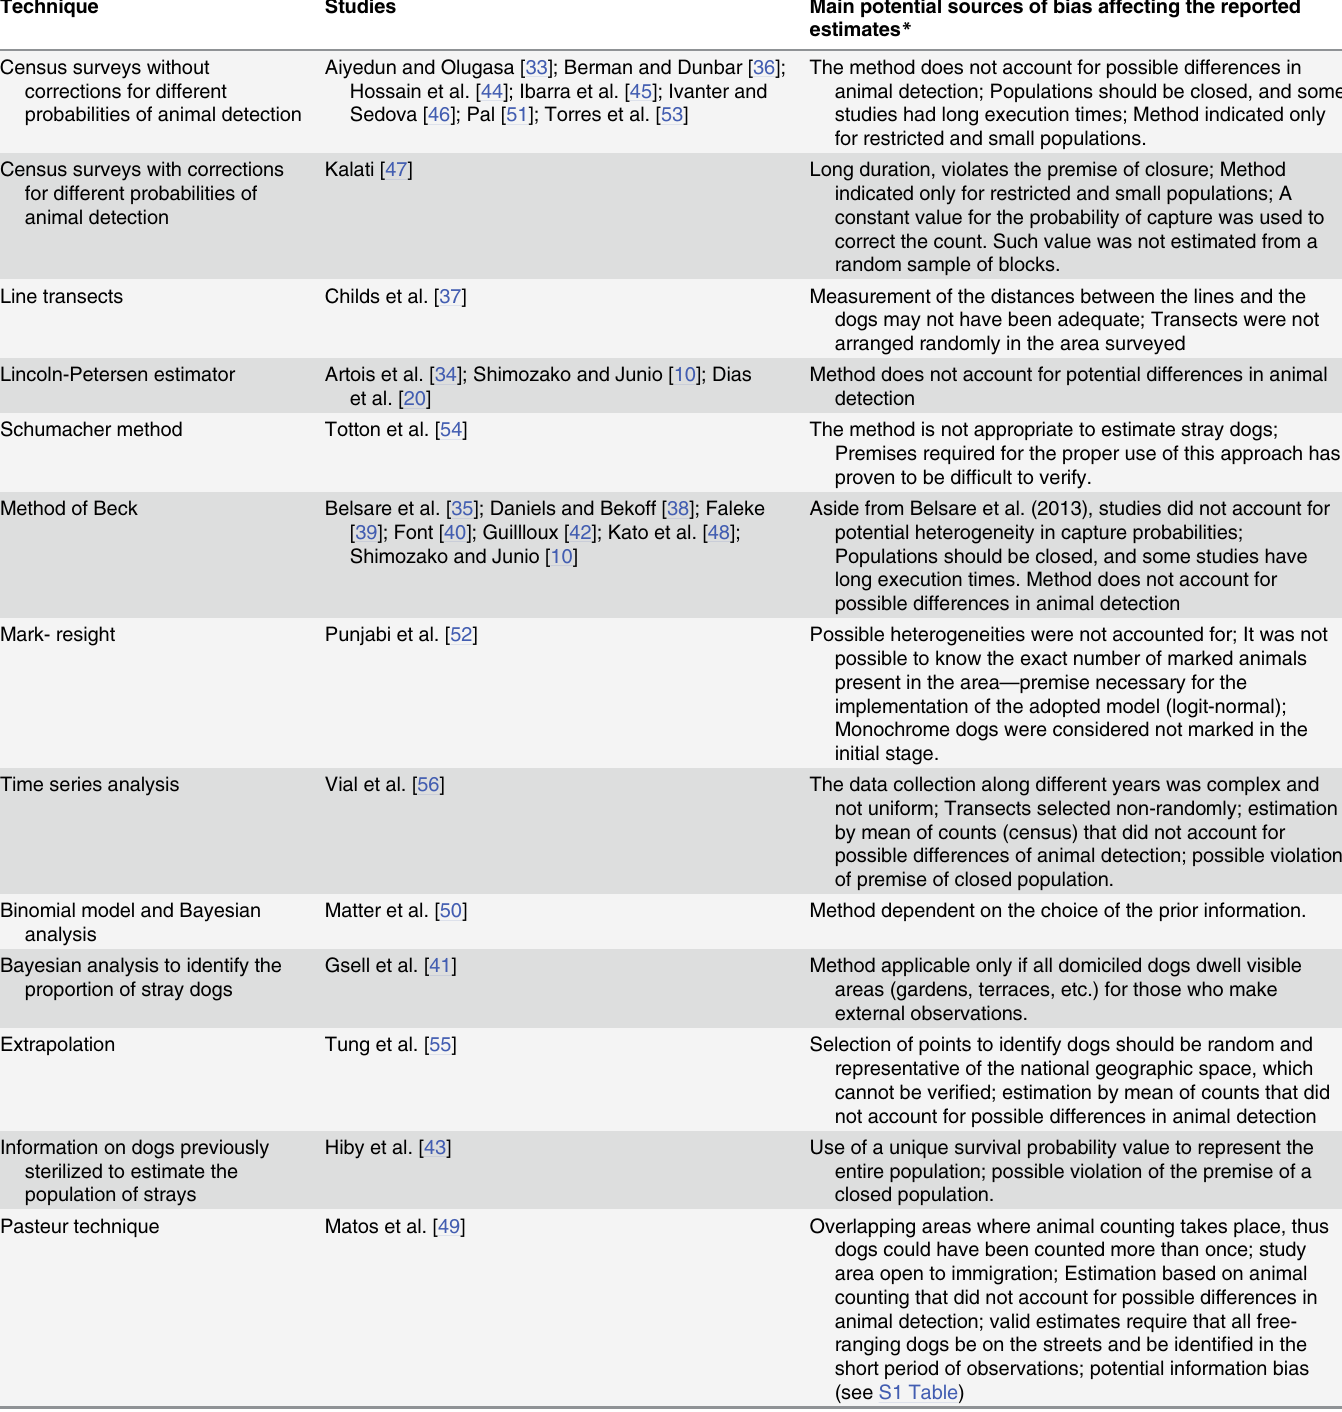
Table 1. Main susceptibility to bias due to the methods used to estimate the abundance of the populations of free-ranging